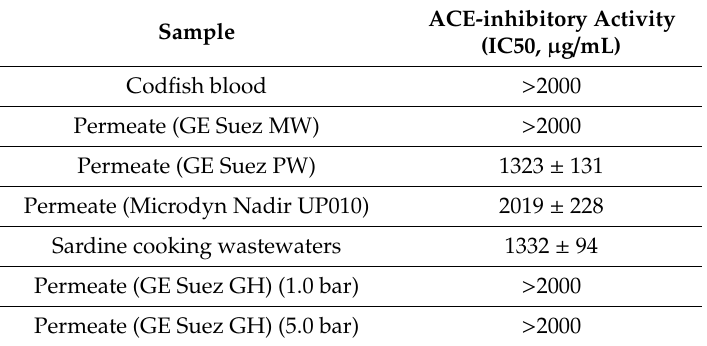
Table 10. Results of ACE inhibitory of codfish blood, sardine cooking wastewaters, and the corresponding